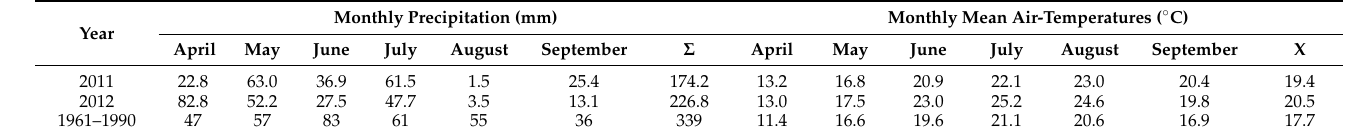
Table 2. Total monthly precipitation and mean air-temperatures at the experimental station during 2011 and 2012.